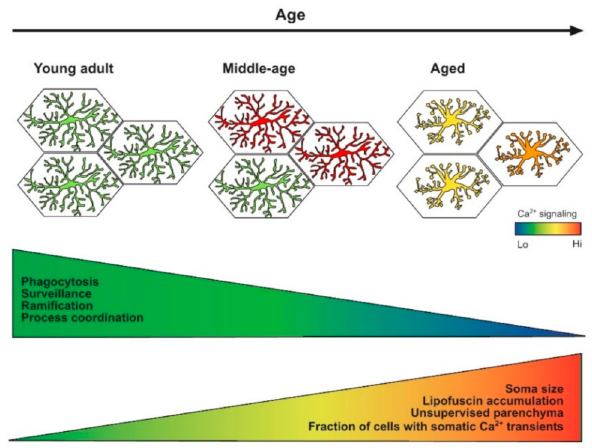
Figure 2. Schematic illustration of the functional states adopted by microglia along the axis of brain aging. See text for further